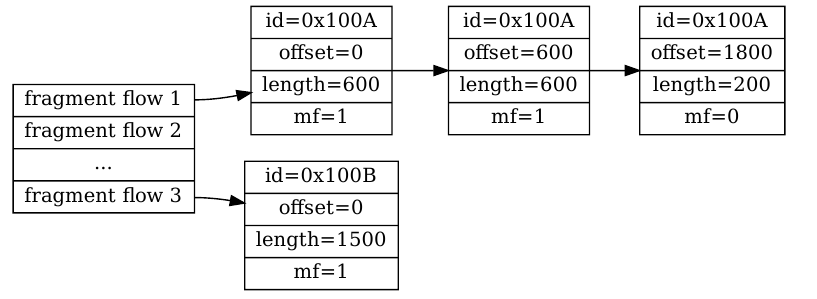
Figure 3. IP Fragment